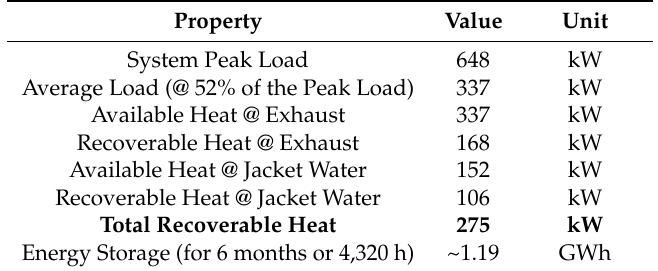
Table 2. Recoverable energy from the 1800 kW gen-set at